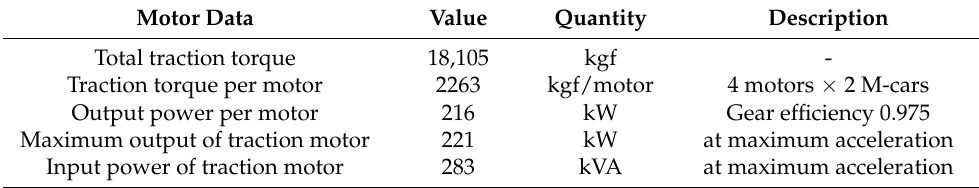
Table 2. Traction motor data for tractive effort